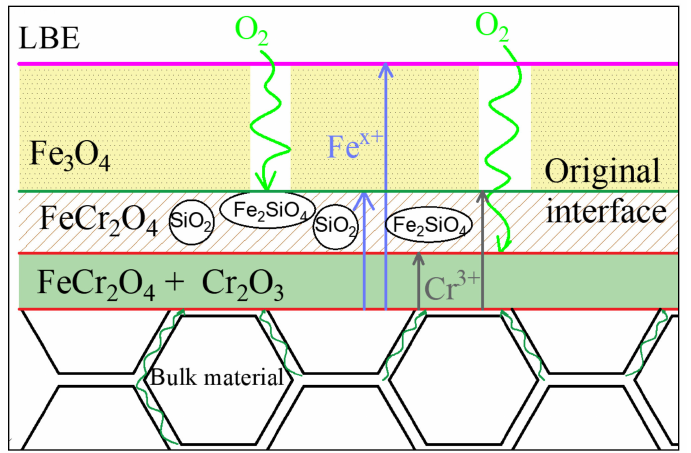
Figure 10. Oxidation of T91 containing